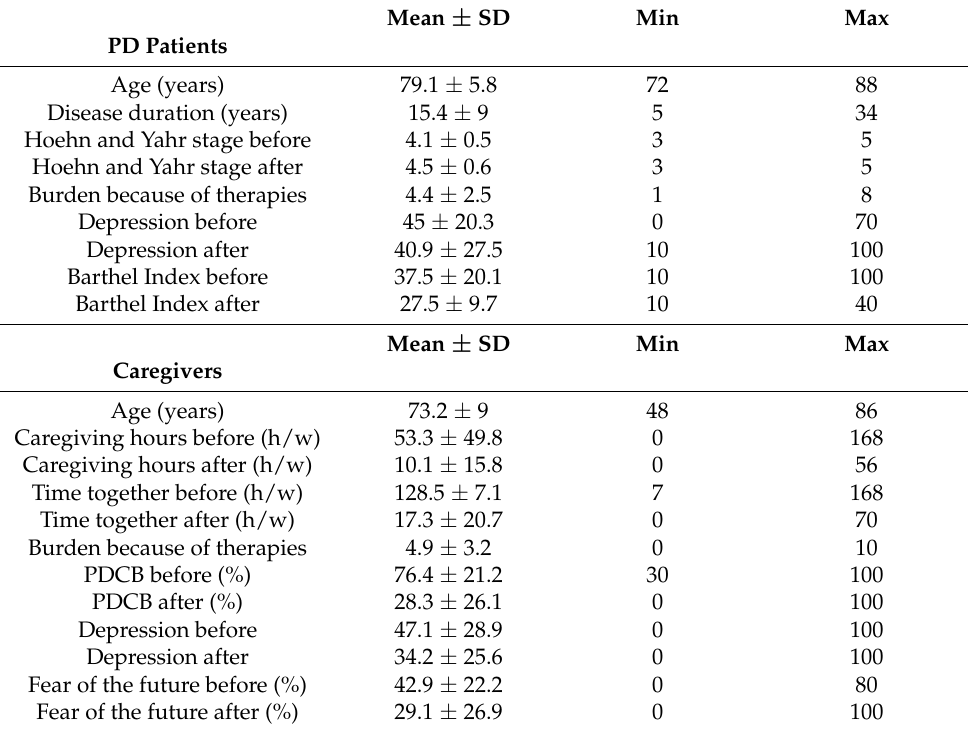
Table 1. Patient ( n = 14, female = 6) and caregiver ( n = 14, female = 10) characteristics before and after transition to institutional